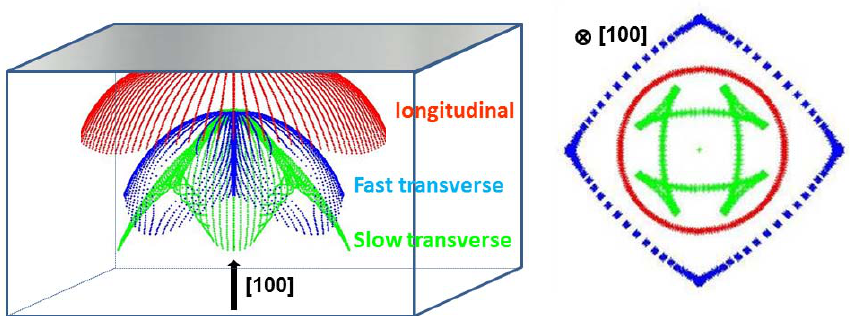
Figure 7. Group velocity surfaces at ambient conditions along the [100] symmetry axis of ZB-cubic silicon. The pump probe delay time here is 3.5 ns. Red, blue, and green dashed lines correspond respectively to the longitudinal, fast, and slow transversal group velocities. Right: surface wave sections along the (100) plane of a cubic zincblende structure)